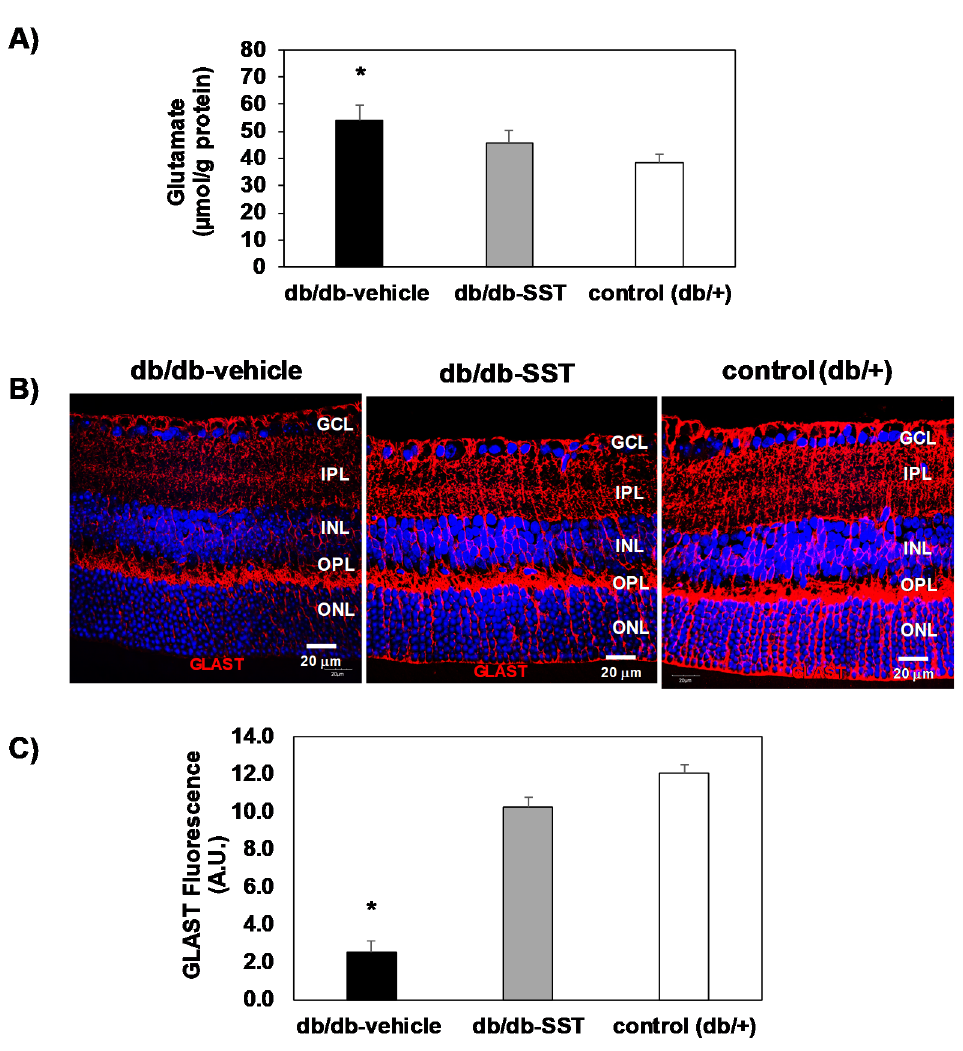
Figure 5. Effect of topical administration of SST in glutamate and GLAST levels in retinas from db/db mice. ( A ) Retinal concentration of glutamate measured by high-performance liquid chromatography in the experimental groups. * p < 0.01 in comparison with the other groups. ( B ) Comparison of GLAST immunofluorescence (red) among representative samples from each experimental group. Nuclei were labeled with Hoechst stain (blue). Scale bars, 20 µ m. ( C ) Quantification of GLAST immunofluorescence in arbitrary units (A.U.). N = 10 mice per group. Results are the mean ± SEM. * p < 0.01 in comparison with the other groups.